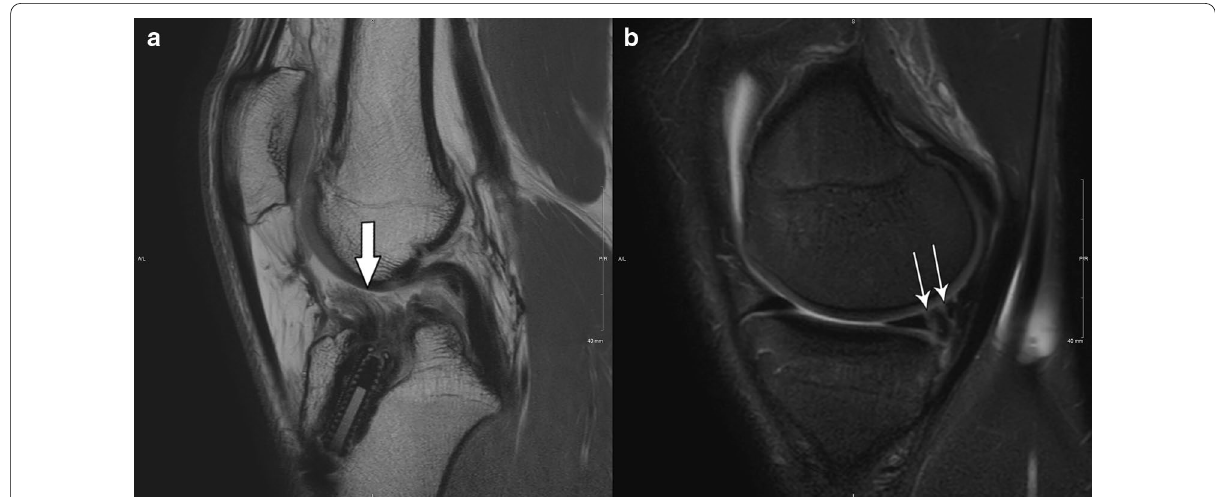
Fig. 15 Type 5 meniscal ramp lesion MRI case. Sagittal PD‑weighted fat‑suppressed MR image ( a , left) shows a postoperative ACL graft tear (arrow), and sagittal T2‑weighted fat‑suppressed ( b , right) shows a double vertical peripheral tear through the posterior horn of medial meniscus (thin arrows). *Case courtesy of Dr. Diego Lemos (USA)